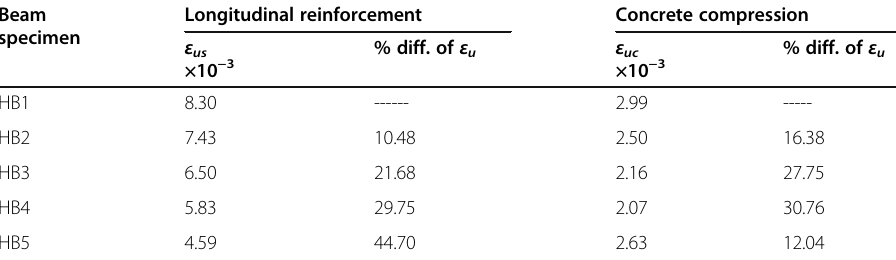
Table 10 Strain characteristics in longitudinal reinforcement and concrete of shallow wide beam specimens Beam specimen